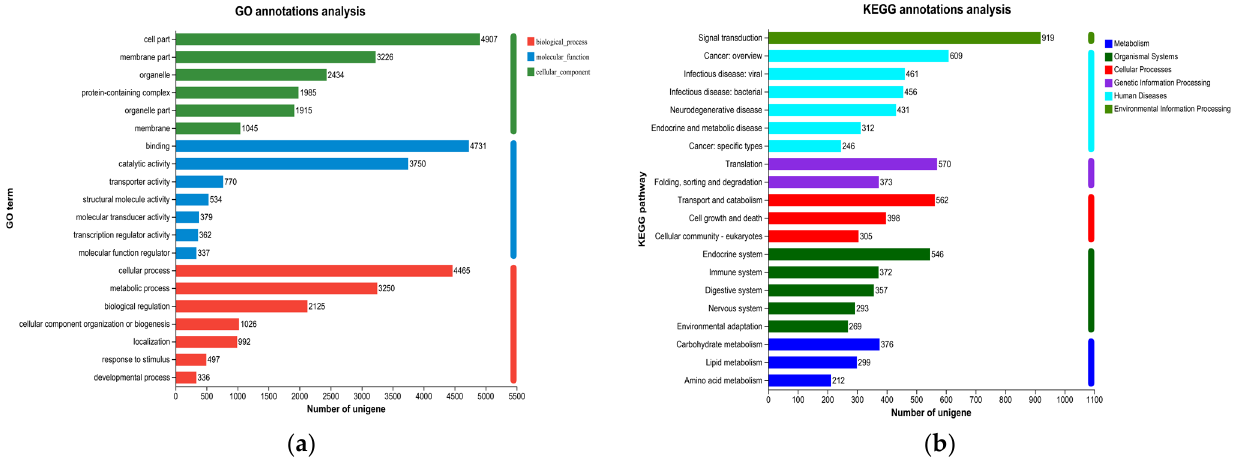
Figure 1. The GO annotations and KEGG pathway analysis of differentially expressed genes (DEGs). (( a ) GO function classification map; ( b ) KEGG pathway classification map).